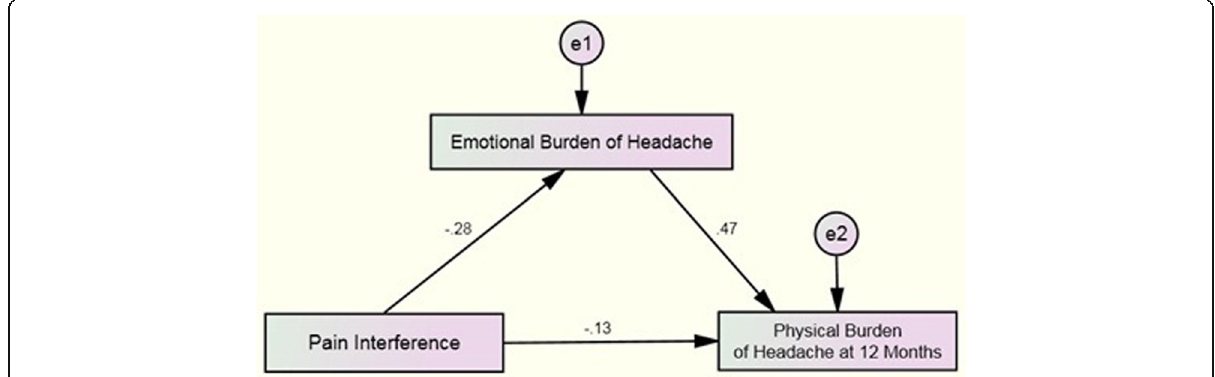
Fig. 2 Mediation Analysis of Pain Interference on Physical Burden of Headache at one-year through Emotional Burden of